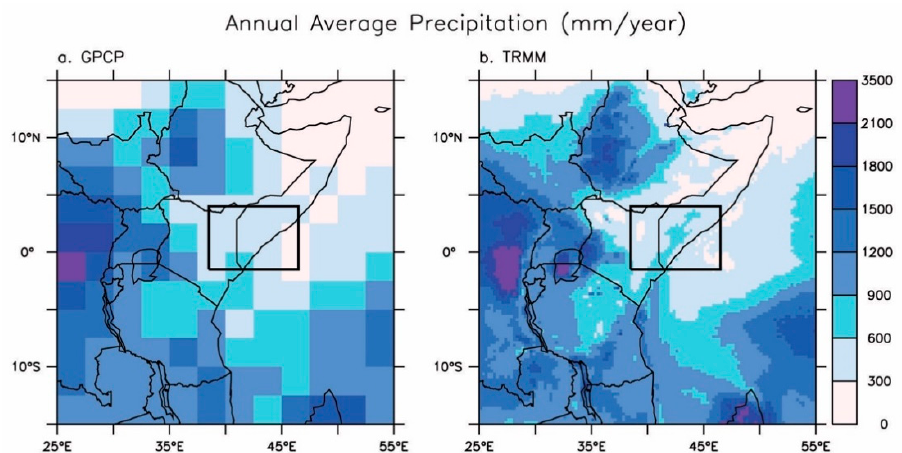
Figure 1. Average annual mean precipitation from Global Precipitation Climatology Project (GPCP; left) and Tropical Rainfall Measuring Mission Multisatellite (TRMM; right) climatology data, demonstrating the variability in rainfall regimes in the area. For zonally averaged values, the drought region is defined as the land area between 1.5°S and 4°N and 38.5°E to 46.5°E (black box).